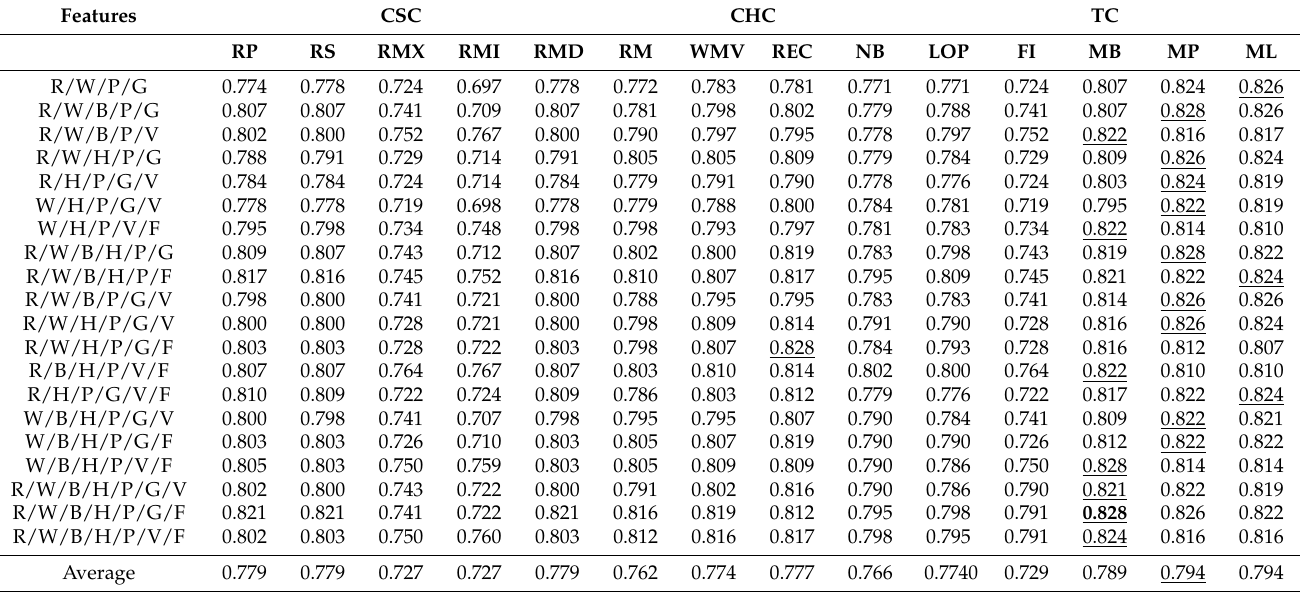
FI 11.682 (12.611), MB 2.767 (3.792), MP 1.984 (2.678), and ML 1.970 (2.739). These results indicate that MP, ML, and MB were the best combiners in both cases. Table 4. Accuracy selection greater than 0.821 for 14-rule combination methods and 247 combinations of eight subspaces in the BU-3DFE data set. CSC: a combination of soft classifiers; CHC: a combination of hard classifiers; TC: trainable classifiers. Best classifier result is underlined. Best feature/classifier is in bold type.